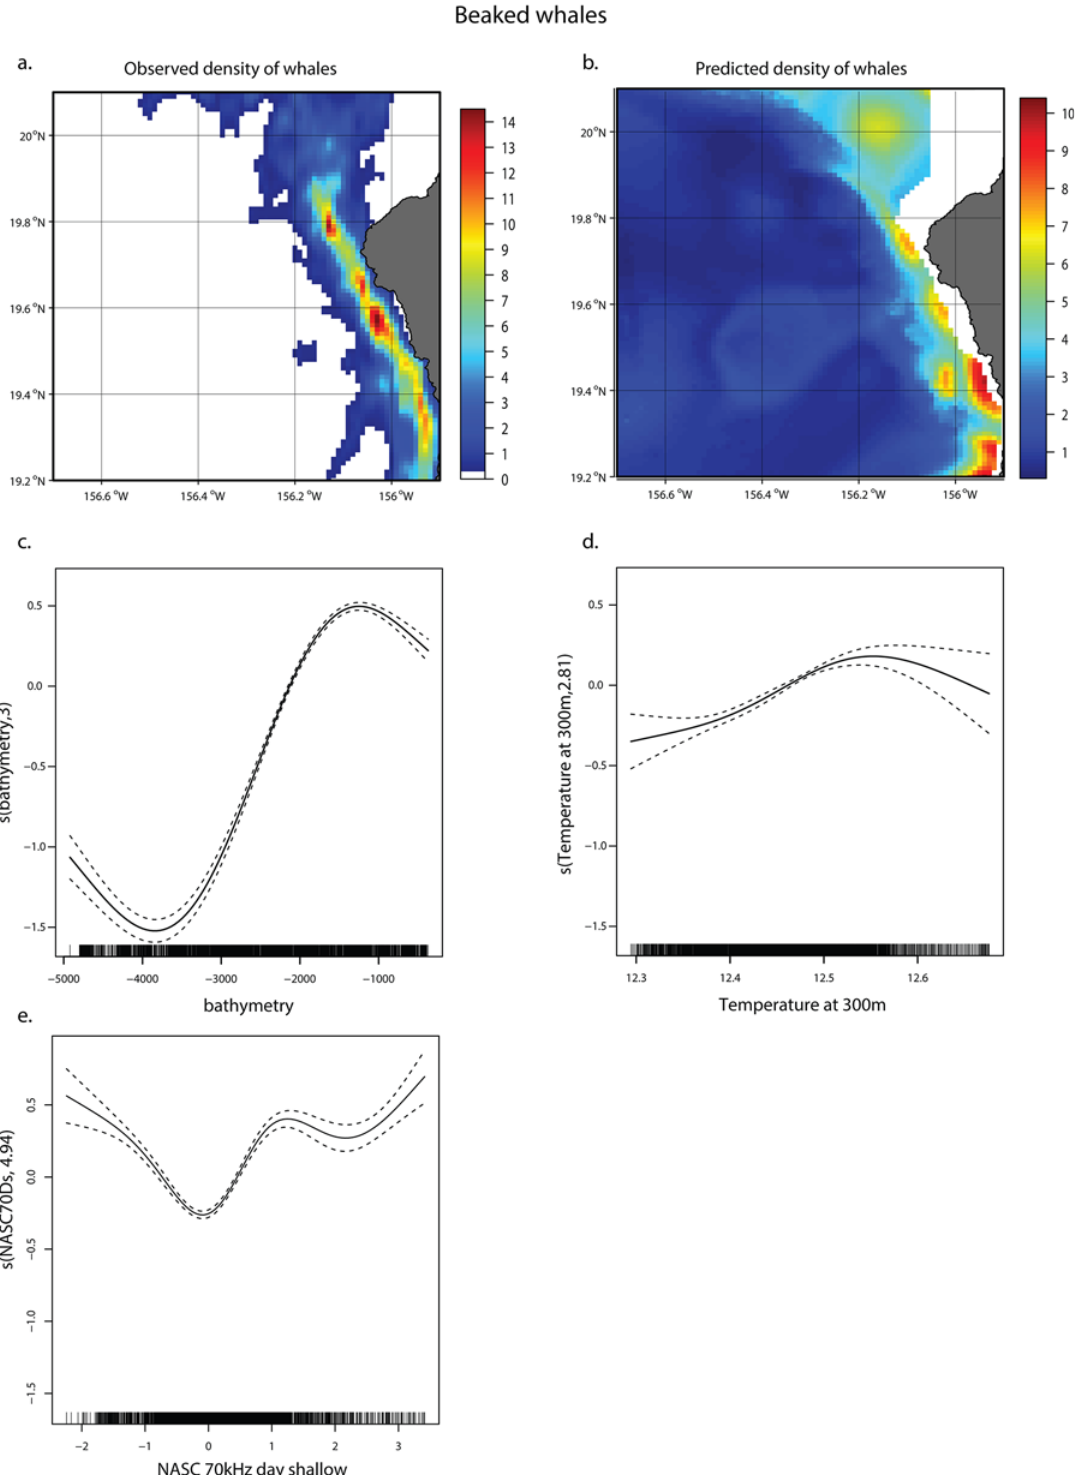
Fig 8. Beaked whale GAMM. Kernel density estimates for Blainville ’ s beaked whale density (a), predicted Blainville ’ s beaked whale density from GAMM (b), smoother from GAMM for bathymetry (c), temperature at 300 m (d), micronekton density in the shallow layer observed on the 70 kHz (e). The two scales are not the same to better reflect where the areas of relative highest densities are, according to the density estimates and the model predictions. Dashed lines represent the confidence intervals around the smoothers.